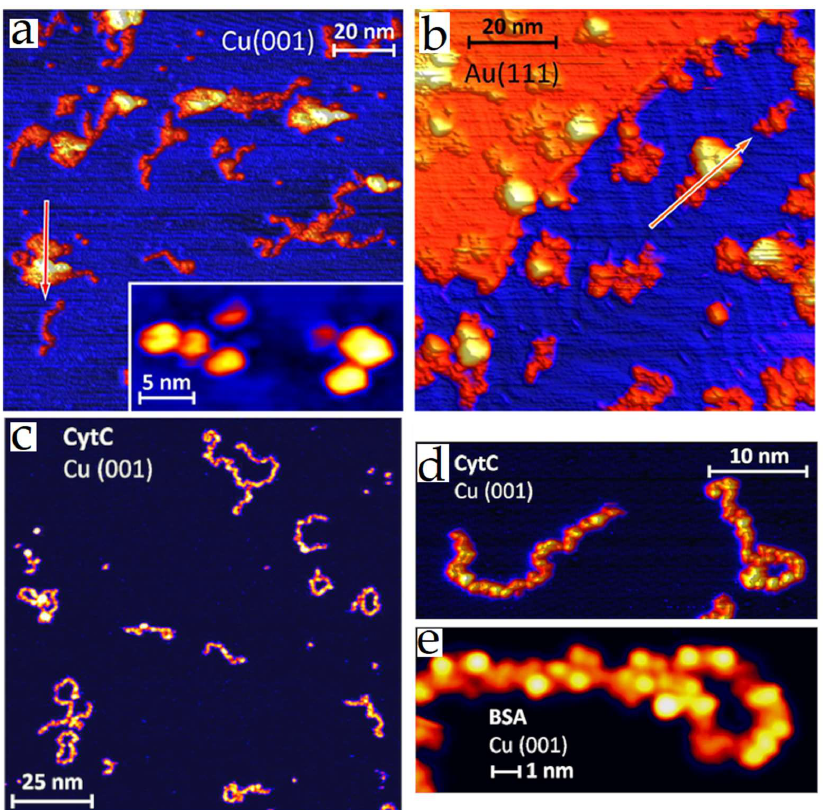
Figure 7. STM images of CytC deposited by the ES-IBD method onto copper ( a , c , d ) and gold surfaces ( b ). Folded proteins displayed a globular structure and unfolded proteins displayed an extended conformation, and the observed lobes on extended proteins were interpreted as amino acids ( d , e ), BSA was used as reference ( e ). Reprinted with permission from Ref. [93]. Copyright (2020), American Chemical Society.